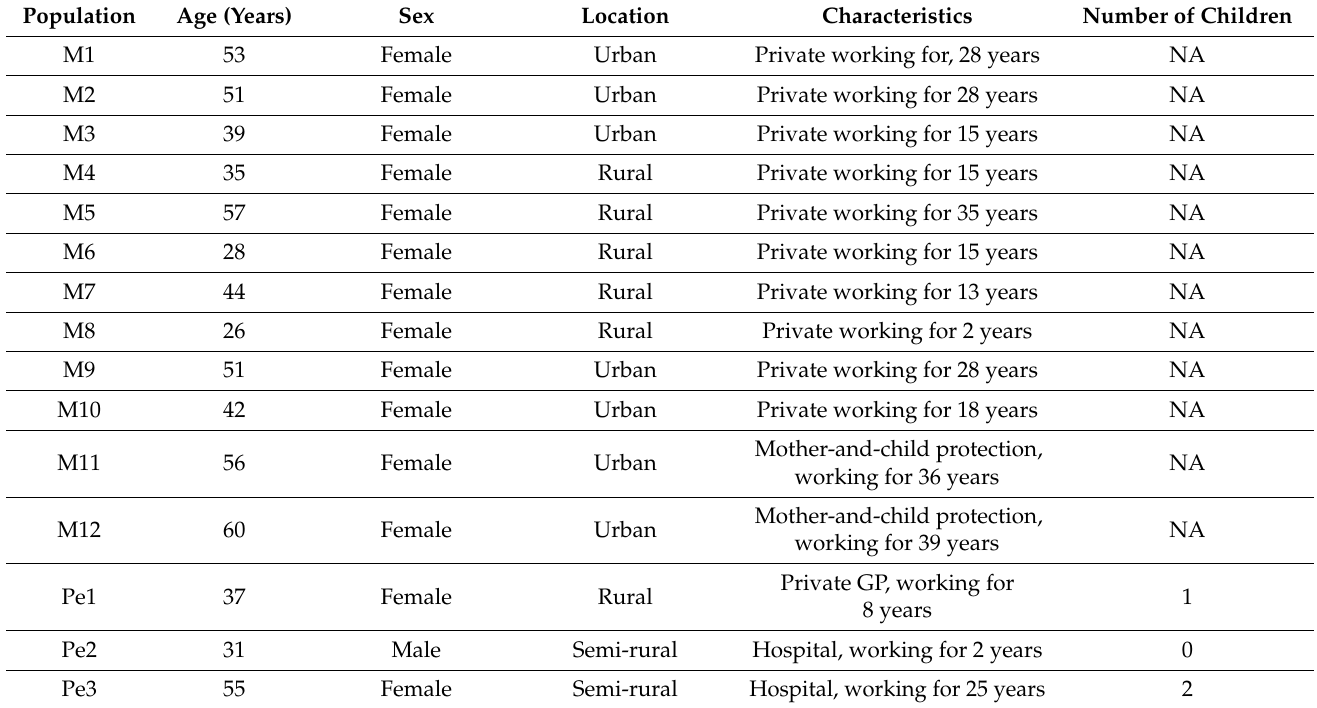
Table 1. Characteristics of qualitative study population (M: midwife; Pe: Paediatrician or GP with a prenatal activity; P: patient from general population; Pa: patient with young children or pregnant